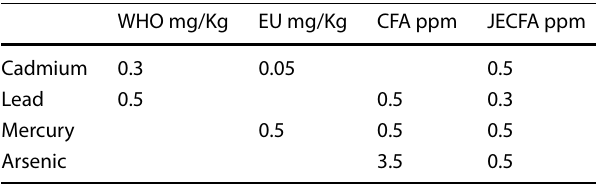
Table 3 Description of allowable level of heavy metals in food items can be consumed by human proposed by renowned interna- tional organizations WHO